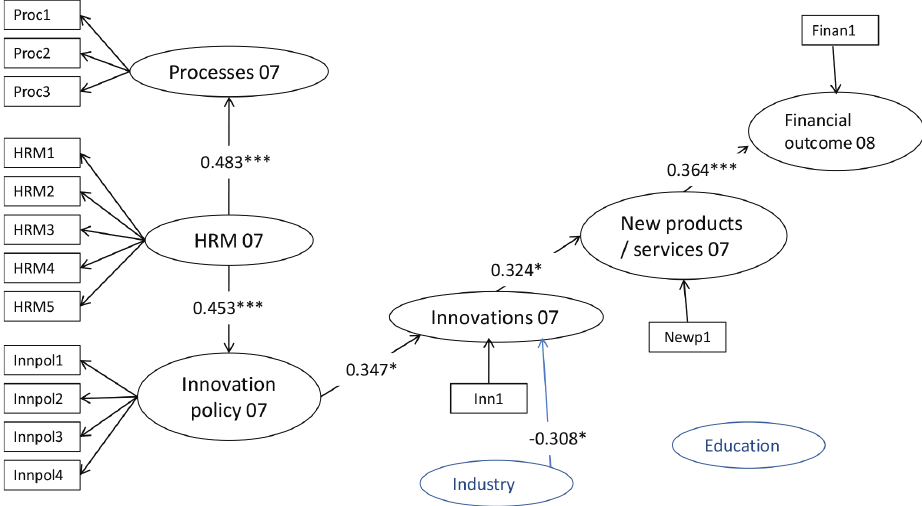
Fig. 2. Results of the estimated model 1